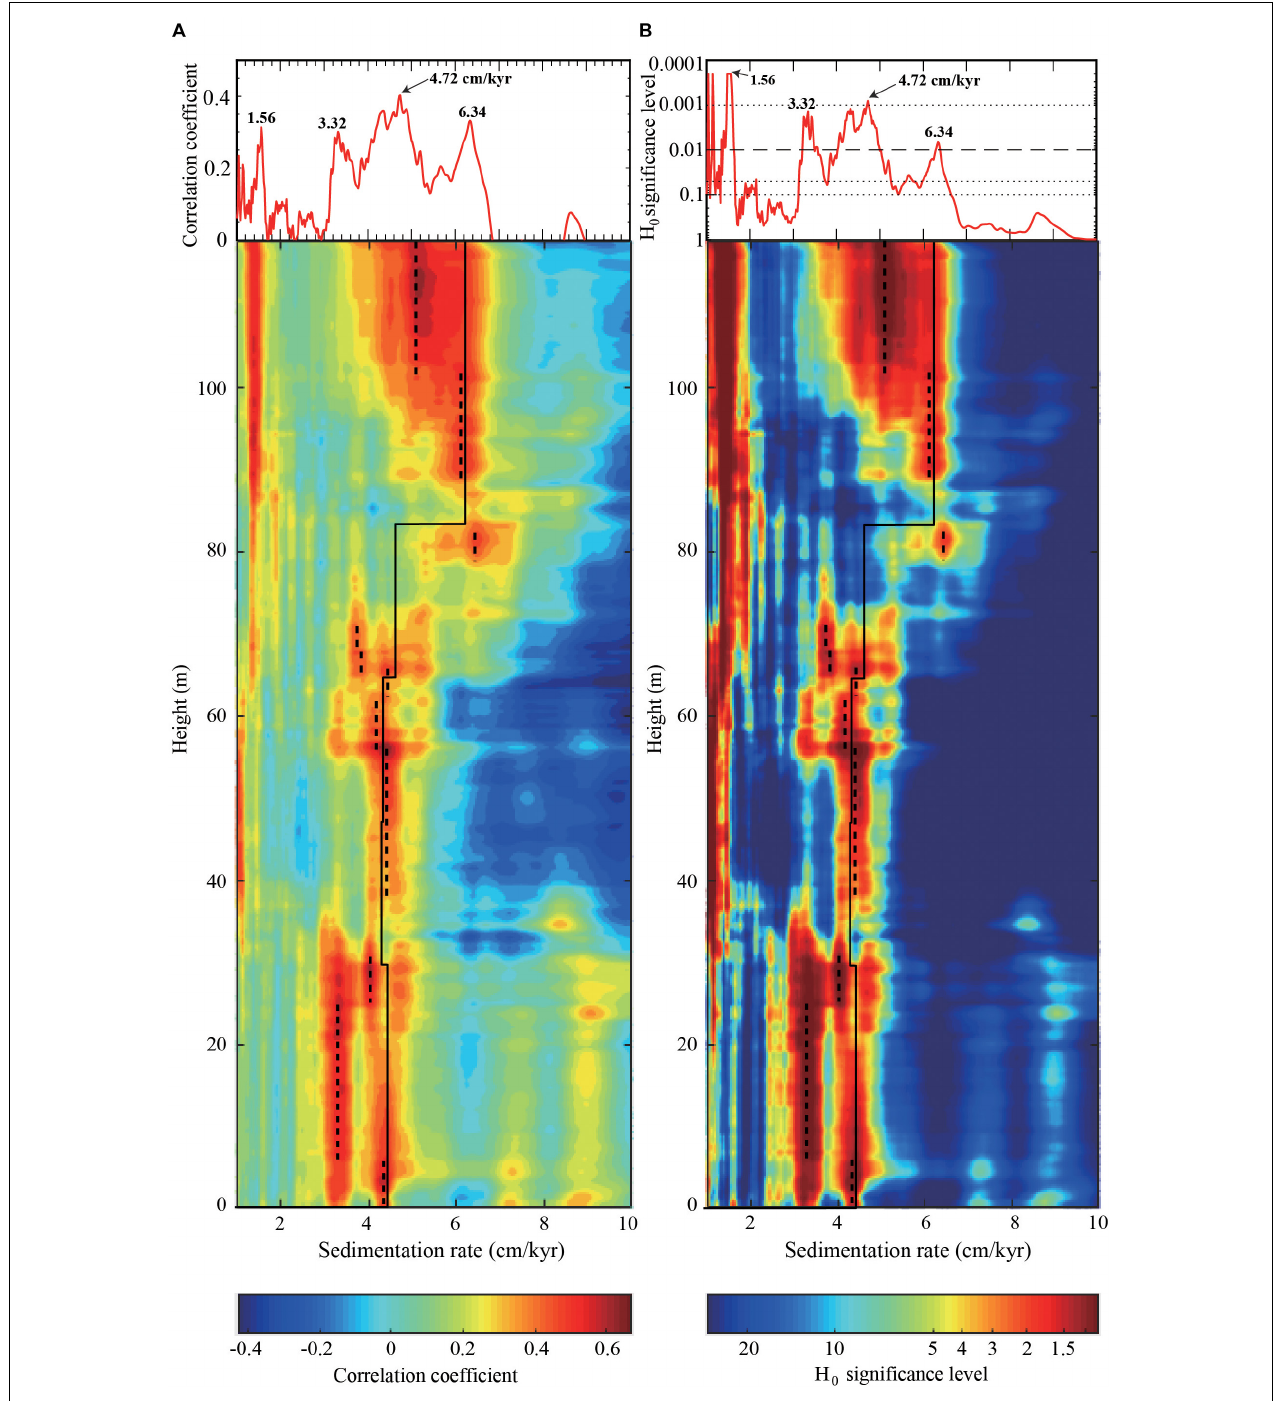
FIGURE 7 | Correlation coefficient (COCO) and evolutionary correlation coefficient (eCOCO) analysis of the DBG MS stratigraphic series. (A) Correlation coefficient vs. test sedimentation rate estimation of the correlation coefficient between the power spectra of astronomical solutions and the DBG MS series indicating an optimal sedimentation rate of 4.72 cm/kyr (top), and a sliding stratigraphic window to track variable sedimentation rates through the MS series (bottom). The vertical black lines indicate sedimentation rates according to the 405-kyr tuning ( Table 2 ); the vertical dashed lines highlight the higher COCO values along the section. (B) The null hypothesis (H 0 ) significance level test (top) and evolutionary null hypothesis (H 0 ) significance level (bottom). For both the COCO and eCOCO, tested sedimentation rates range from 1 to 10 cm/kyr with a step of 0.02 cm/kyr, and the number of Monte Carlo simulations is 5000. For eCOCO analysis, the sliding window size is 38 m; the sliding window step is 0.02 m. In the top graph: the dashed horizontal line indicates H 0 = 0.01; the horizontal dotted lines, from top to bottom, indicate H 0 = 0.001, 0.05, and